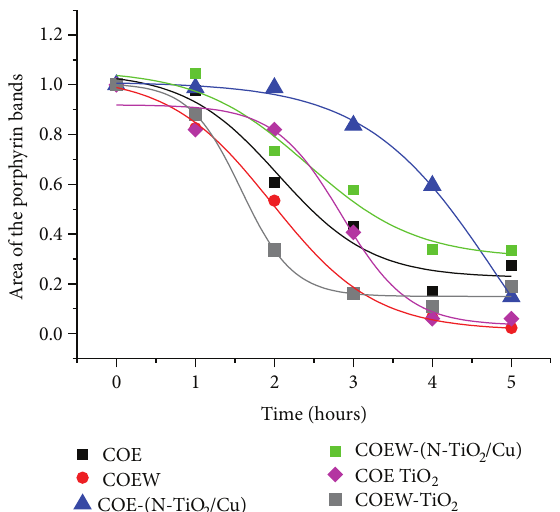
Figure 8: Time evolution of the area of the 𝛼 and 𝛽 bands as a consequence of the photodegradation.